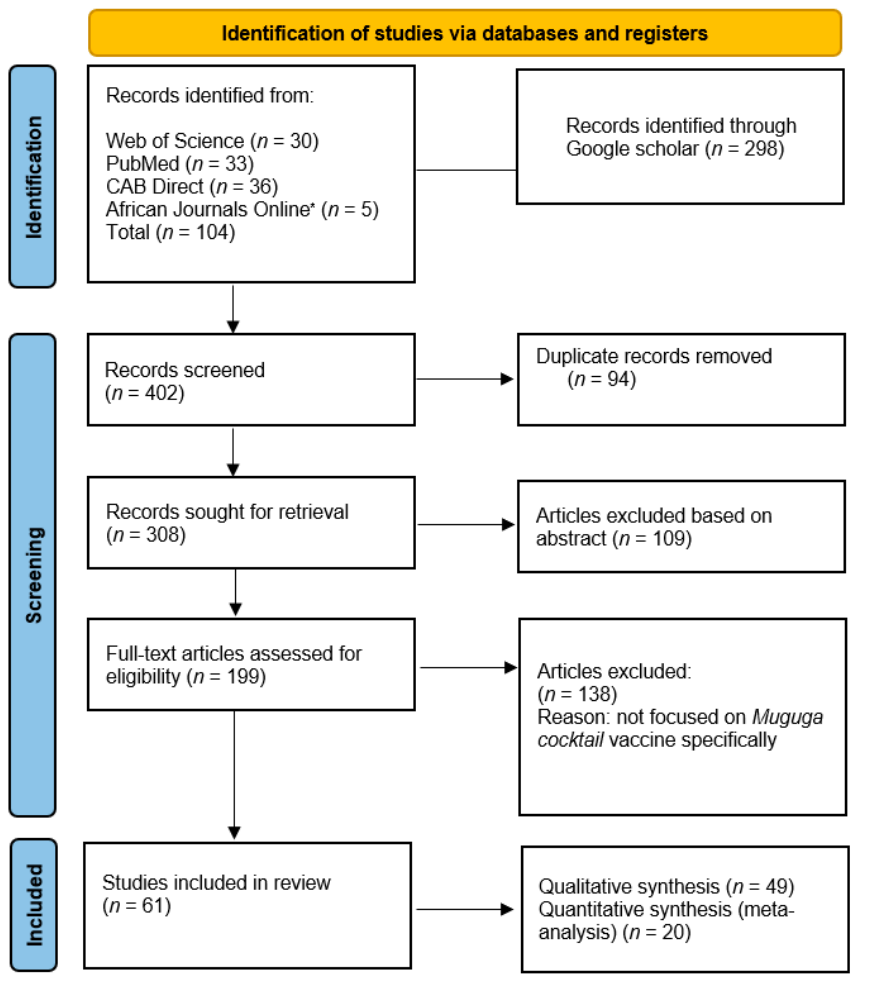
Figure 1. PRISMA flow diagram for article screening and inclusion (adapted from [28]). All 402 articles identified in the literature search were assessed as relevant. Ninety-four duplicates were removed, as well as a further 109 articles, based on abstract content. On full-text assessment, 138 articles were excluded, resulting in 61 articles to be included in the review.